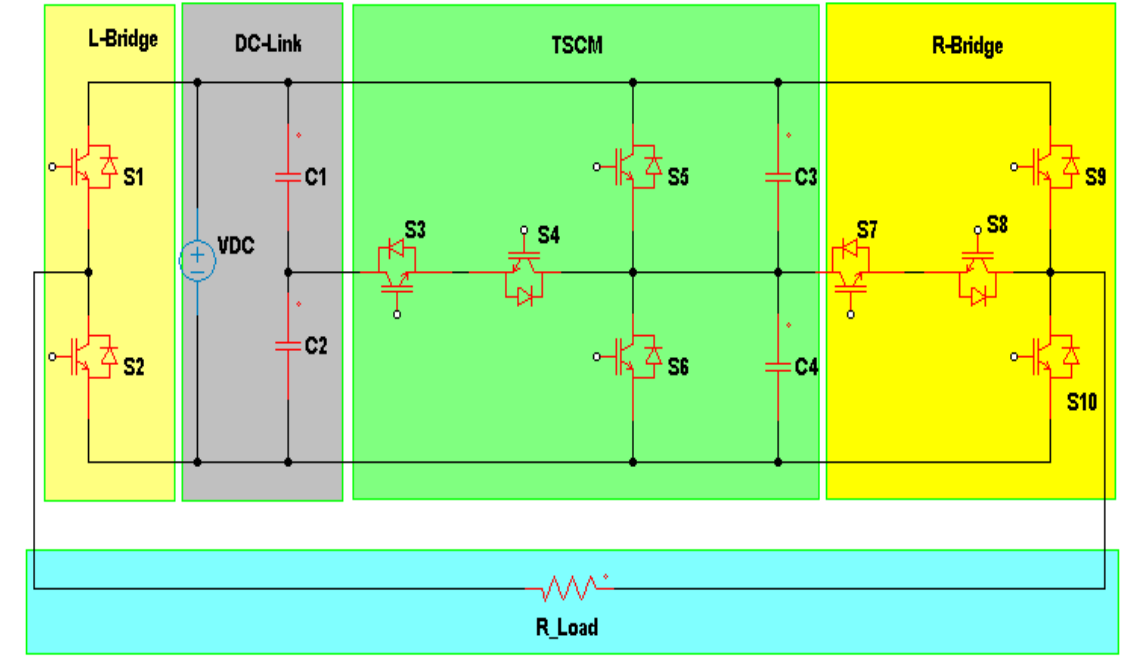
Figure 10. A nine-level inverter based on cascading of T-Type modules.